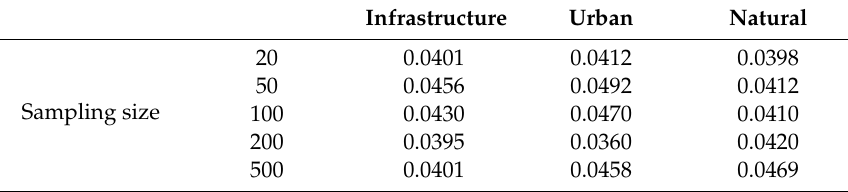
Table 9. Proportion of times that the null hypothesis has been rejected for the QC3 (true